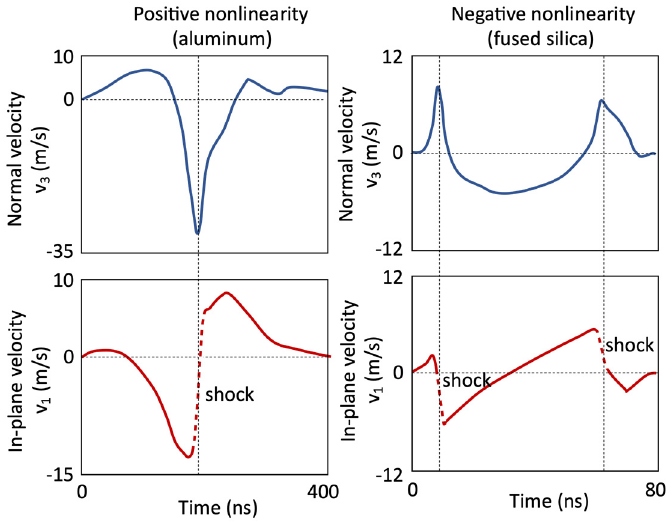
Figure 1. Nonlinear Rayleigh particle velocity waveform sketches based on [14].